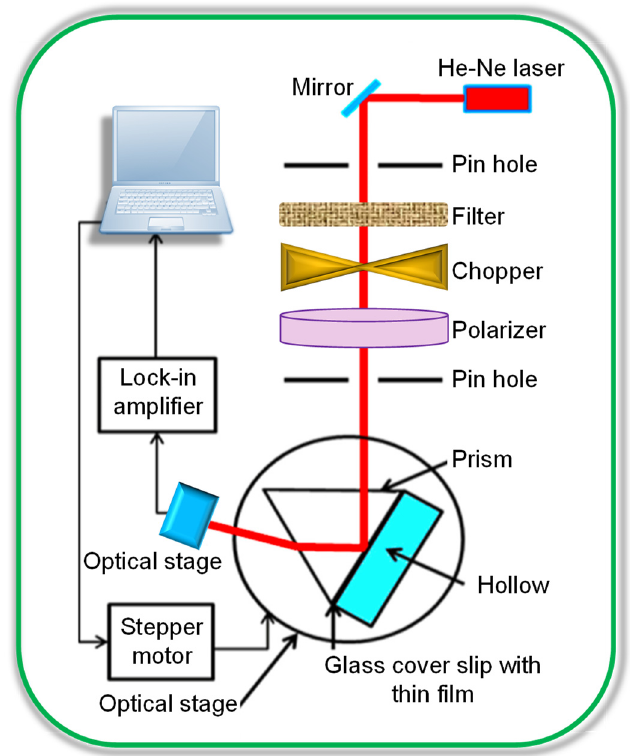
Figure 30. Schematic representation of an surface plasmon resonance (SPR)sensor. Adapted from Ramdzan et al. [361].